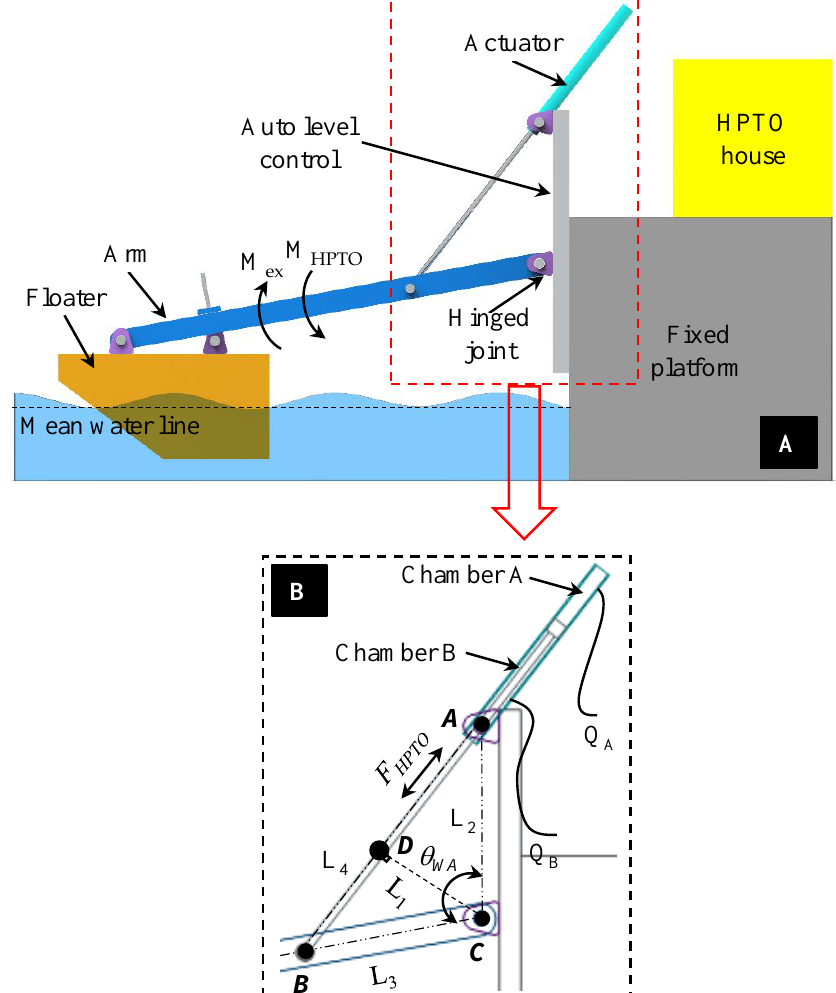
Figure 1. Schematic diagram of the considered WECs. ( A ) A complete system diagram, and ( B ) the enlarged diagram of the interconnection between the WA device and the HPTO